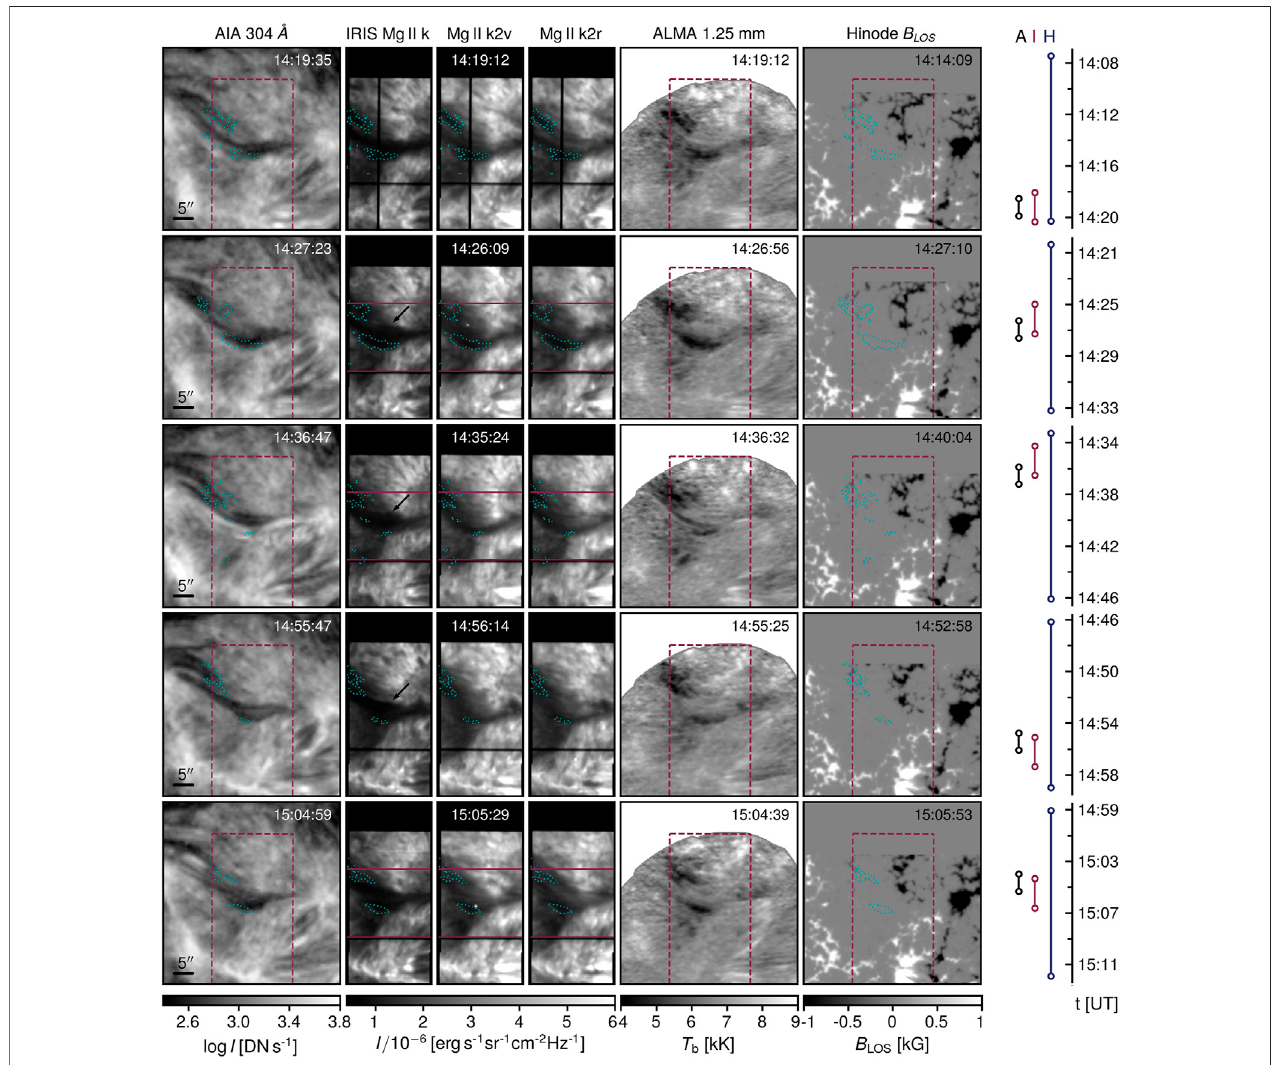
FIGURE 2 | Time evolution of the AR fi lament. The AIA 304 Å images have been averaged within the time span needed by ALMA to mosaic the fi lament. The intensities are capped for display purposes. The time stamps on the IRIS and Hinode raster images correspond to the central slit position. The dashed boxes show the IRISFOV.Thecyancontoursshow T b (1.25 mm)=5,000 K.Thehorizontalmagentalinesdelimittheareadisplayedin Figure3 .Thedataacquisitiontimesareshownon the